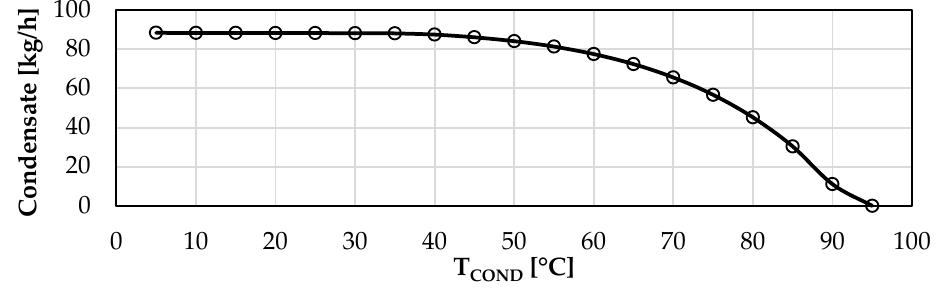
Figure 4. Condensate stream as a function of the condenser working temperature (T COND ).